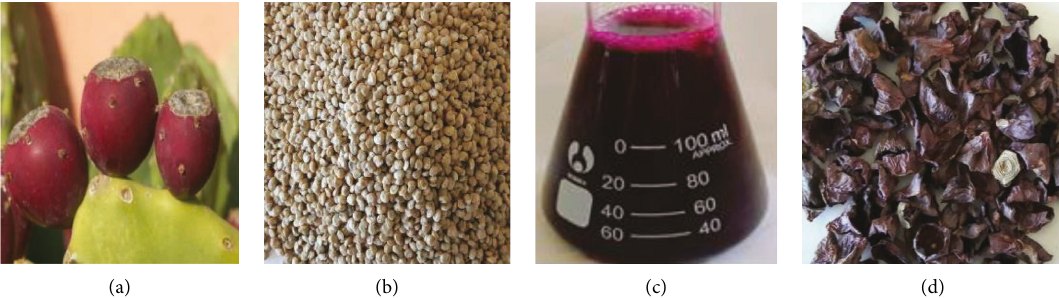
Figure 1: O. dillenii fruits (a), seeds (b), juice (c), and peel (d). Opuntia dillenii (seeds, juice, peel) (Dried and powdered)